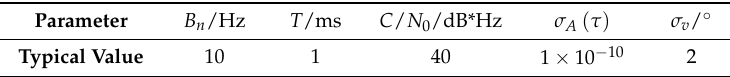
Figure 3. The relationship between the DDGF measurement and the carrier phase error in one frequency. Table 2. The parameters for estimating the theoretical threshold.